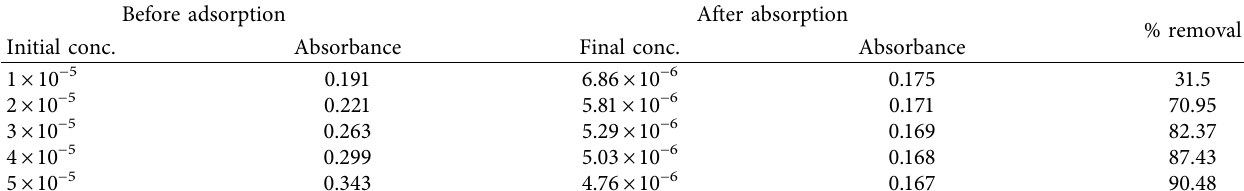
Table 8: Adsorption of methyl orange at different concentration.